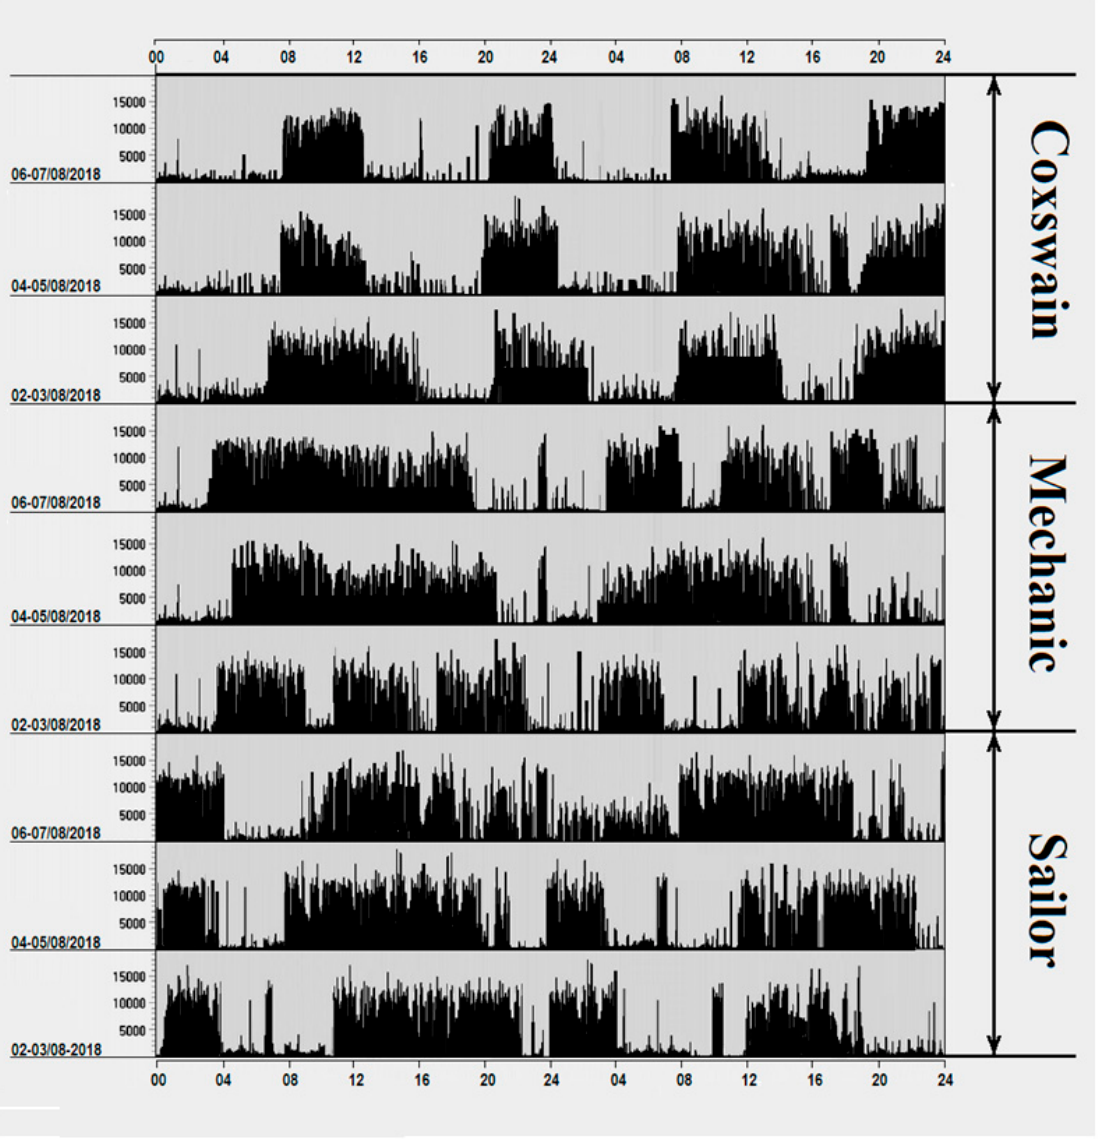
Figure 14. Real work and sleep schedule (determined by the actigraph) of the three subjects for a two-day time interval.